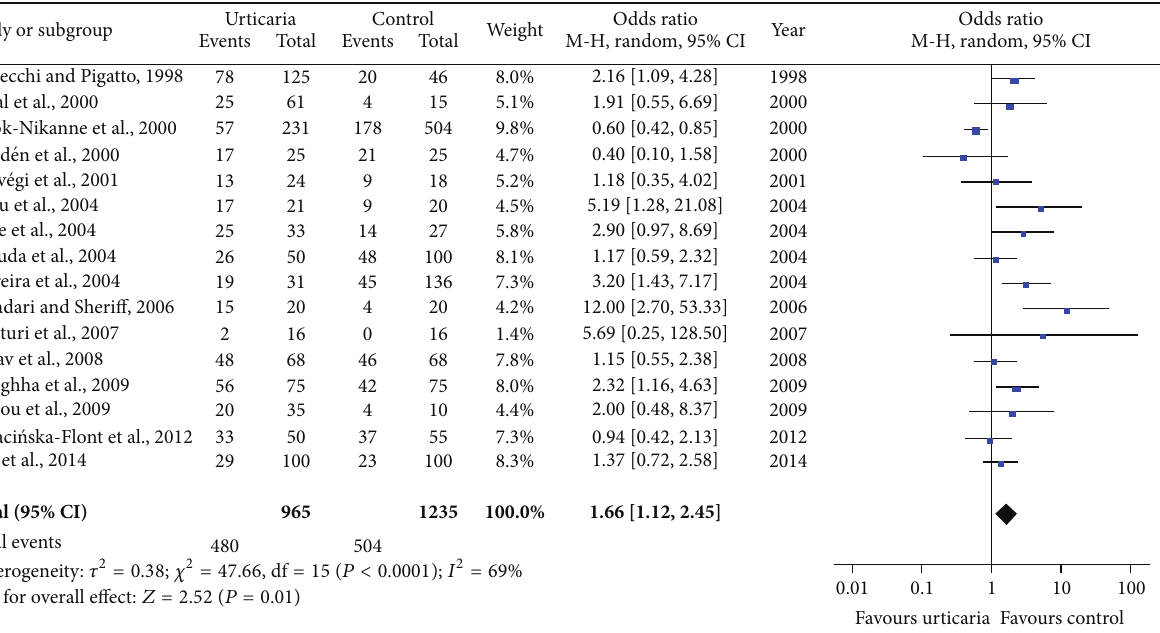
Figure 2: Meta-analysis for the association between H. pylori infection and chronic